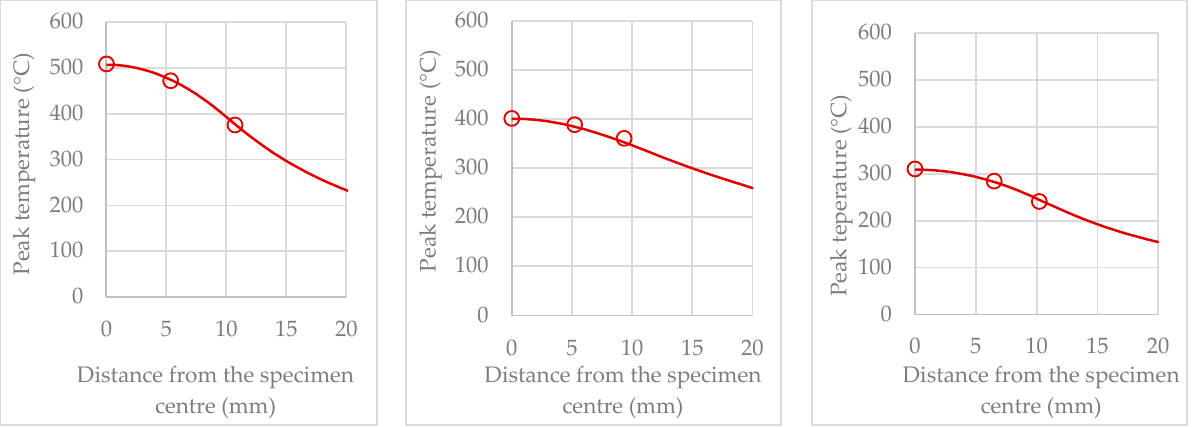
Figure 17. Estimated temperature profiles in physical simulation tests of thermal cycles with treatment speed of 5 mm/s.